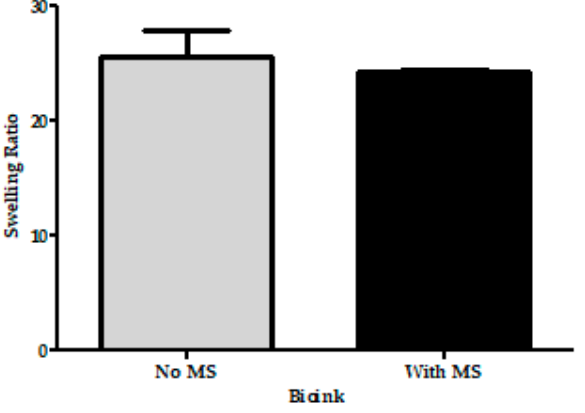
Figure 12. Swelling ratio of bioprinted construct with and without microspheres.